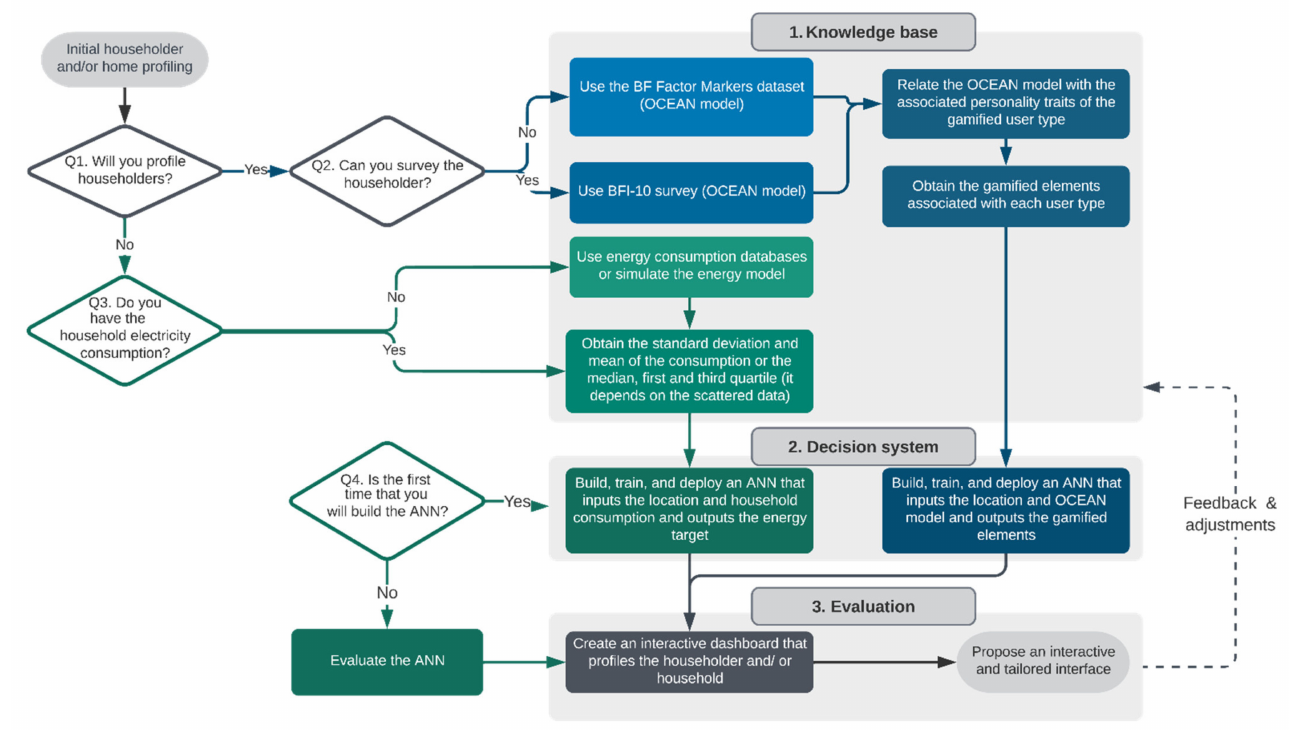
Figure 2. Diagram flow for the socially connected interface